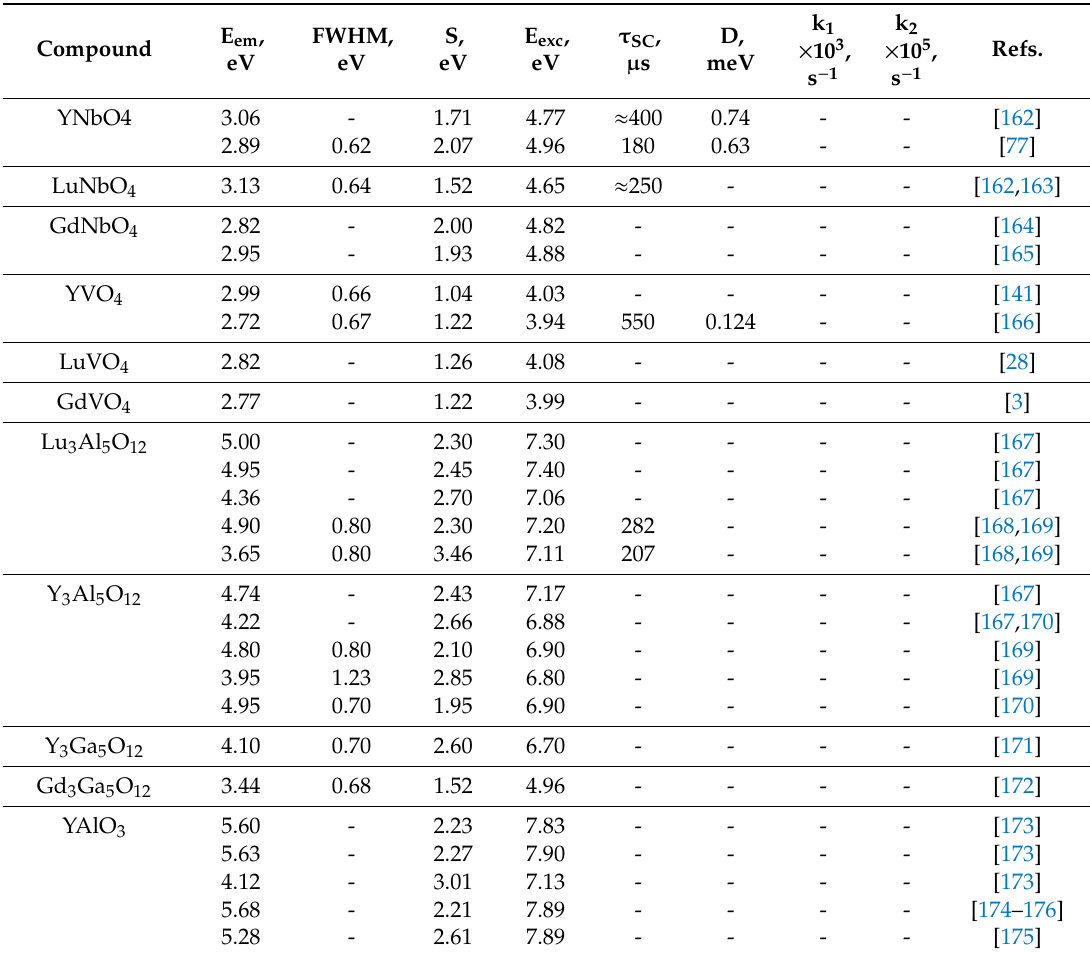
Table 3. Emission peak positions (E em ), full widths at half maxima (FWHM), the Stokes shifts (S), positions of the lowest-energy excitation band (E exc ), and decay times ( τ SC ) (at 0.4 K for PbWO 4 and 4.2 K for the other materials) of the triplet exciton-like emissions of the undoped compounds. The spin-orbit splitting energy (D) and the probabilities of the radiative decay of the metastable (k 1 ) and emitting (k 2 ) levels of the triplet